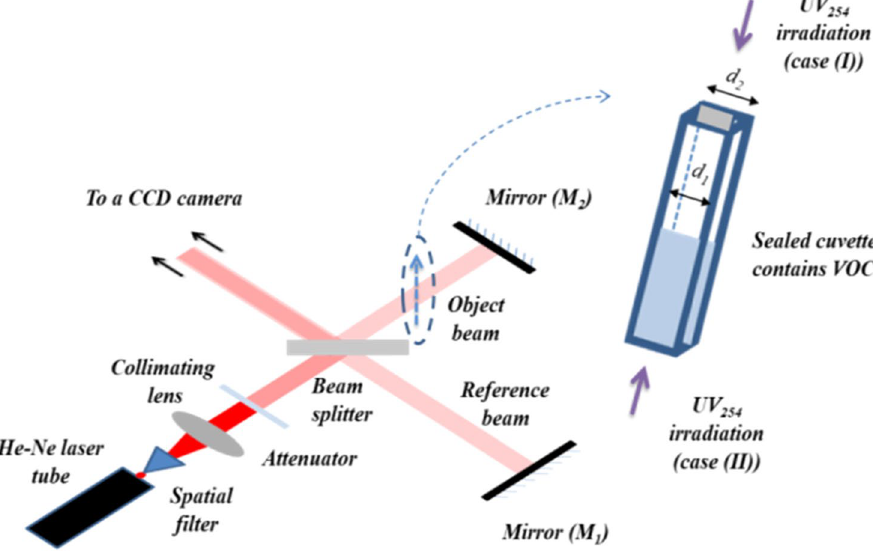
Figure 1. A schematic diagram shows the setup of Michelson interferometer used to study the variations of refractive index profiles of the UV 254 irradiated